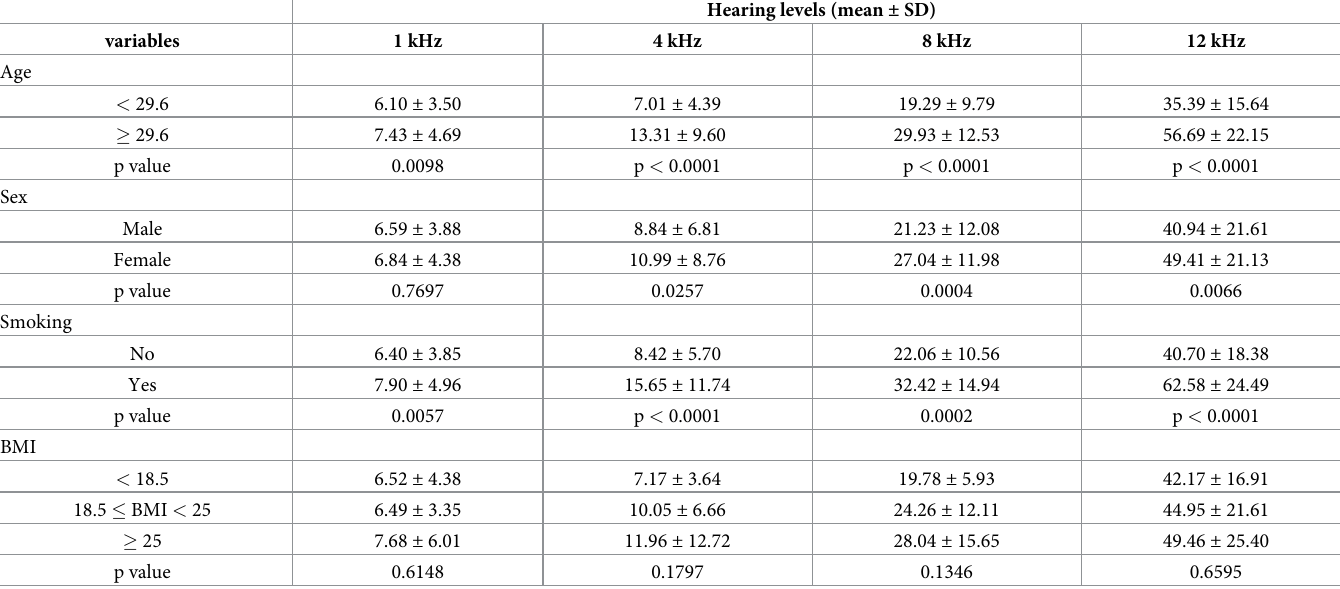
Table 2. Associations between hearing levels and confounding factors including age, BMI, sex and smoking.